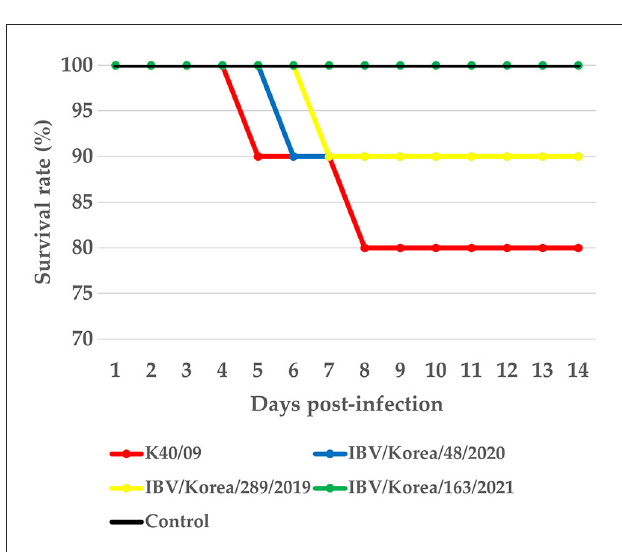
FIGURE4 Survival rate of chickens infected with IBV